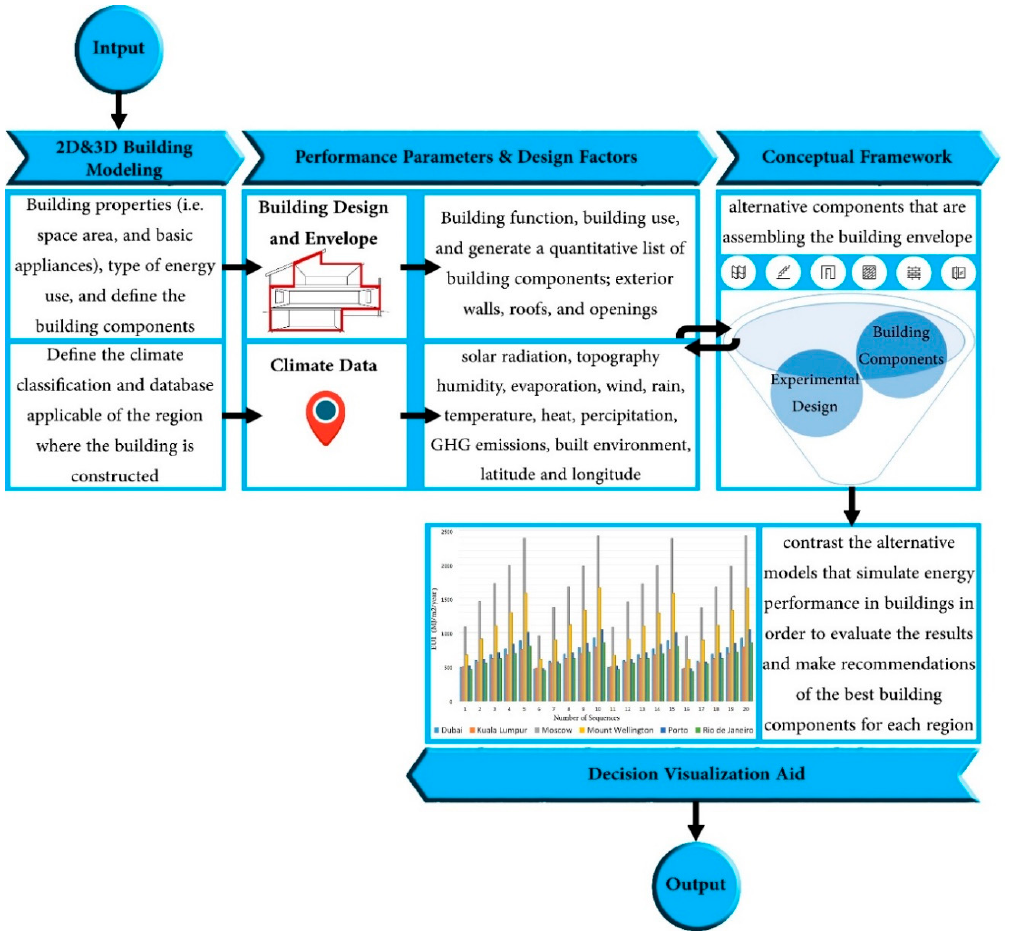
Figure 5. A methodological framework for increasing energy performance in construction projects.